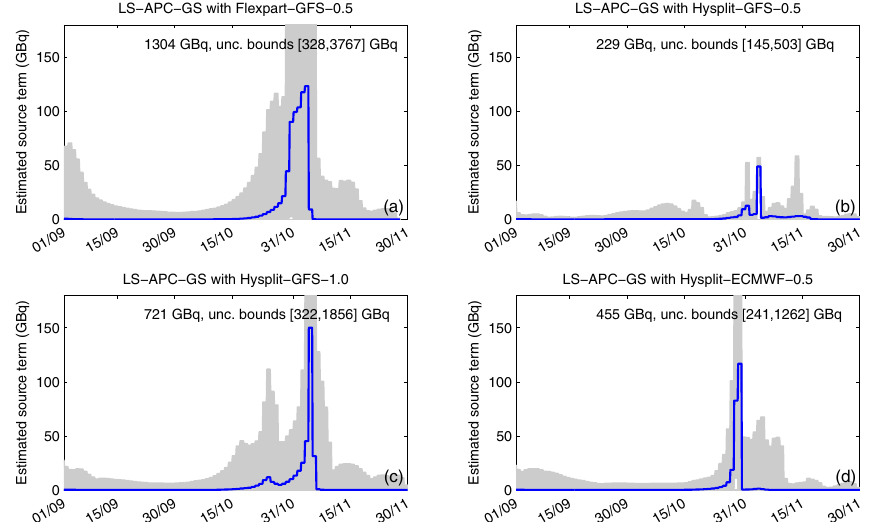
Figure 10. Estimated source terms at locations selected by the marginal likelihood method, shown in Fig. 8, with excluded measurements from Budapest using the LS-APC-GS algorithm for all four tested combinations of dispersion models and meteorological data: Flexpart- GFS-0.5 (a) , Hysplit-GFS-0.5 (b) , Hysplit-GFS-1.0 (c) , and Hysplit-ECMWF-0.5 (d) . The estimated source terms are accompanied by the uncertainty regions of the 5th and 95th percentile (gray filled regions). The estimated activity for the whole period is reported inside each plot with its associated uncertainty